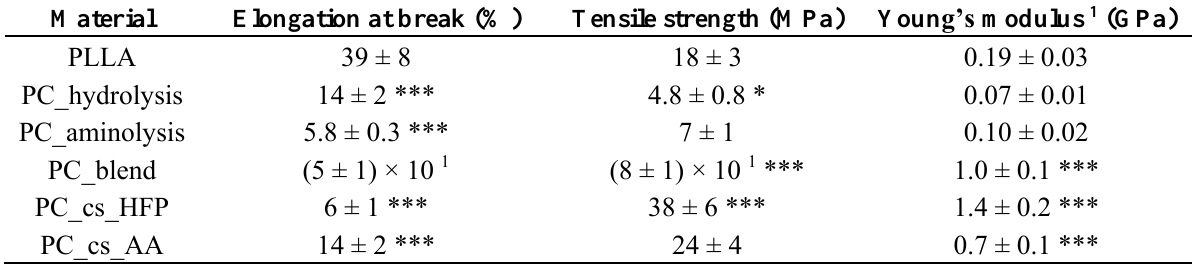
Table 4. Mechanical properties of PLLA/collagen electrospun materials: means and standard deviations of Young’s modulus 1 , tensile strength and elongation at break values of the six scaffolds